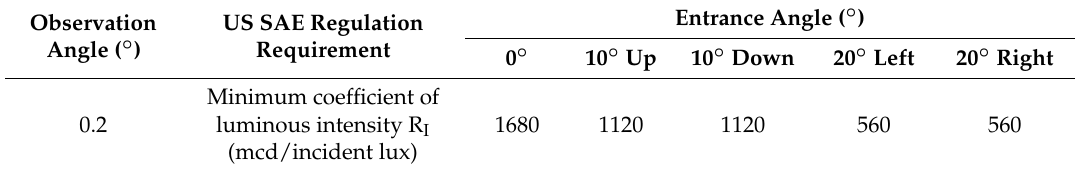
Table 1. Minimum mcd (millicandela)/incident lux for a white reflex reflector. SAE, Society of Automotive Engineers.